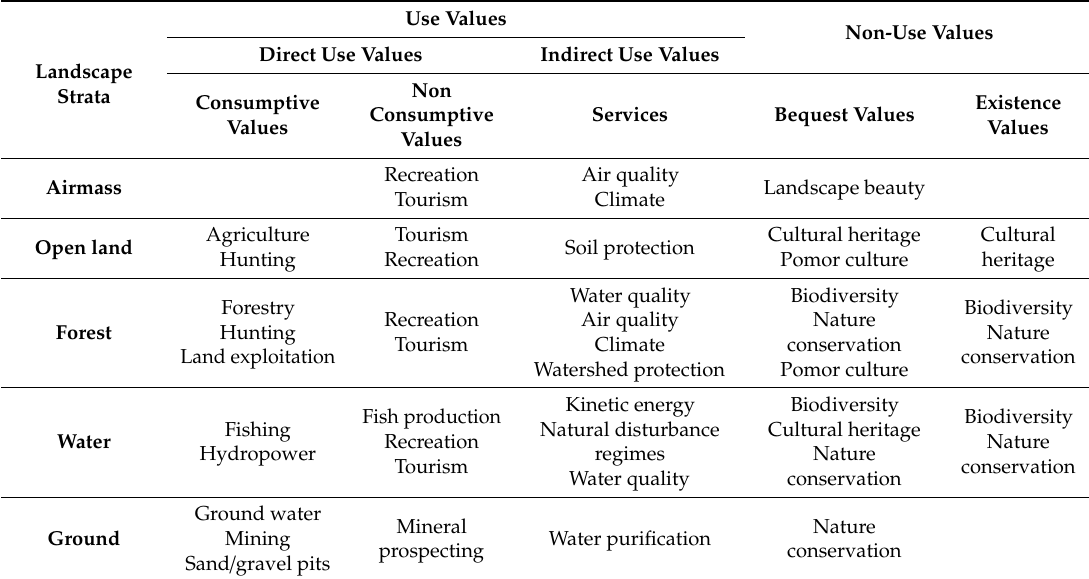
Table 3. Landscape goods, services and values [33] used by di ff erent stakeholders in the lower part of the Kovda River